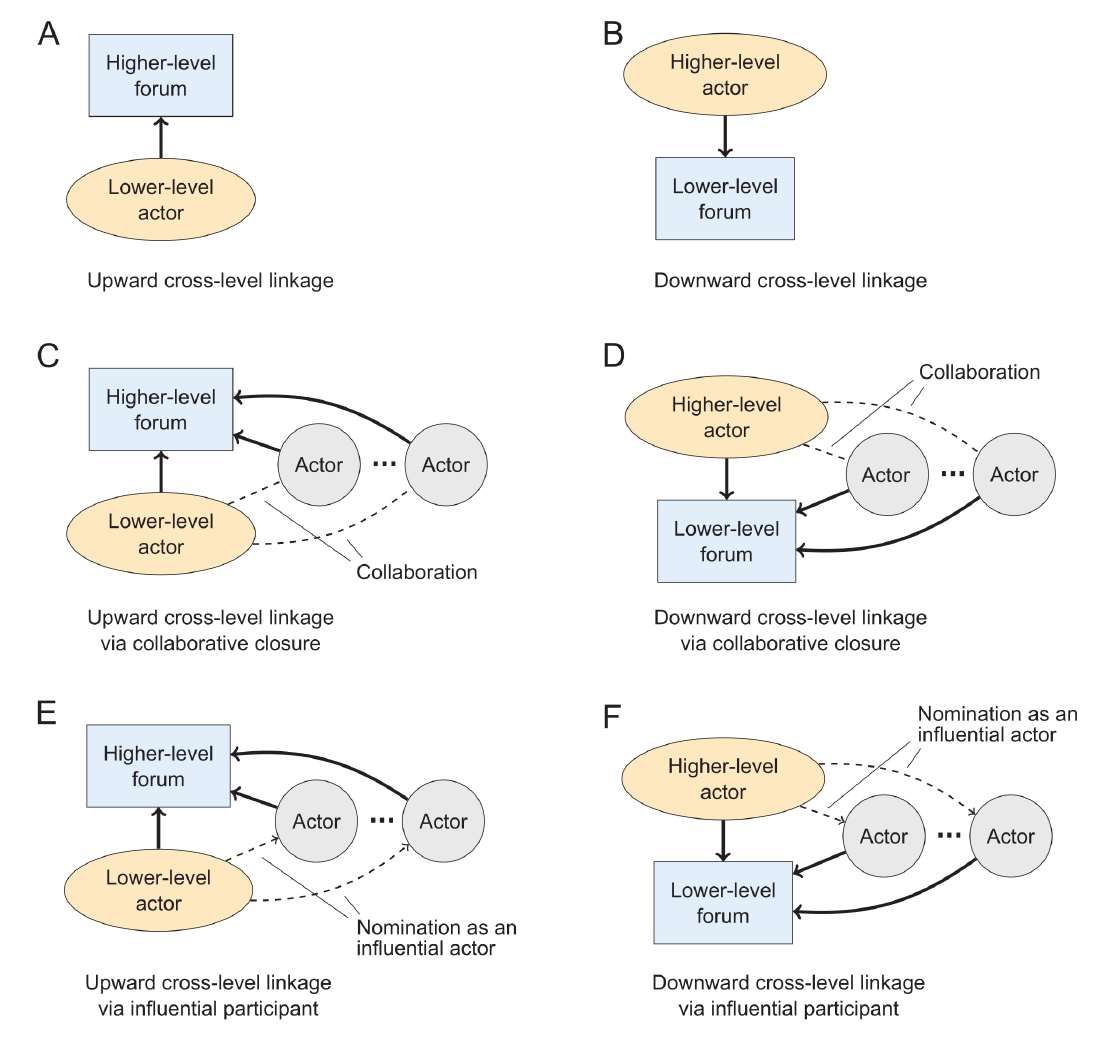
Fig. 1 . Substructures involving cross-level linkages in which policy actors (yellow ovals) participate in climate change adaptation policy forums (blue rectangles) at higher or lower levels. In the diagrams, solid lines indicate actor-forum participation and dashed lines indicate relationships between pairs of